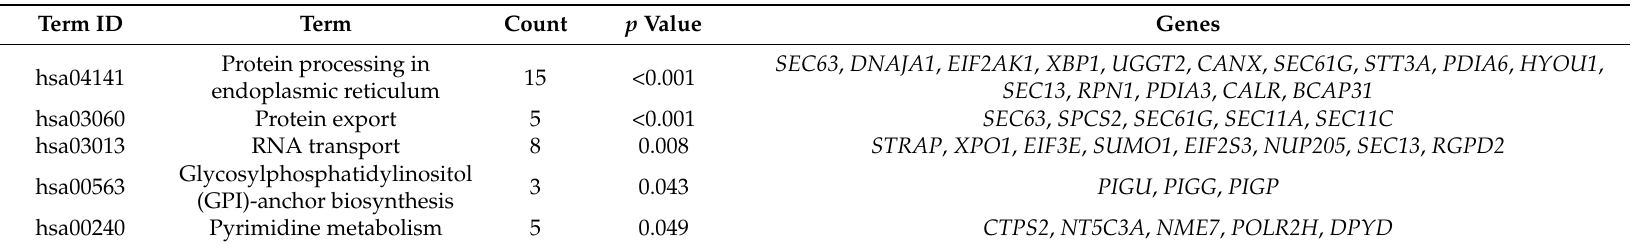
Molecular function ontology